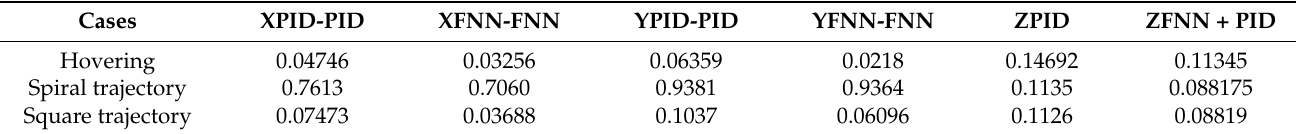
Table 4. Position RMSE values of experiments.